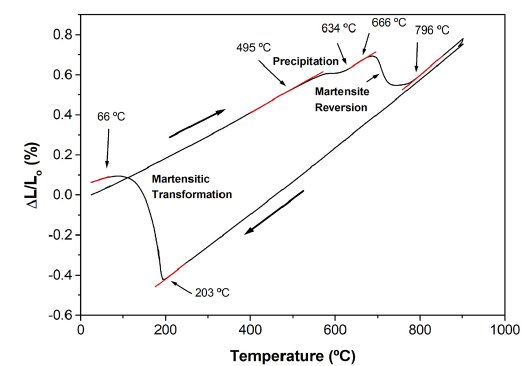
Figure 3. Dilatometric curve of heating and cooling for a maraging 350 steel, heating rate =1°C/s 20